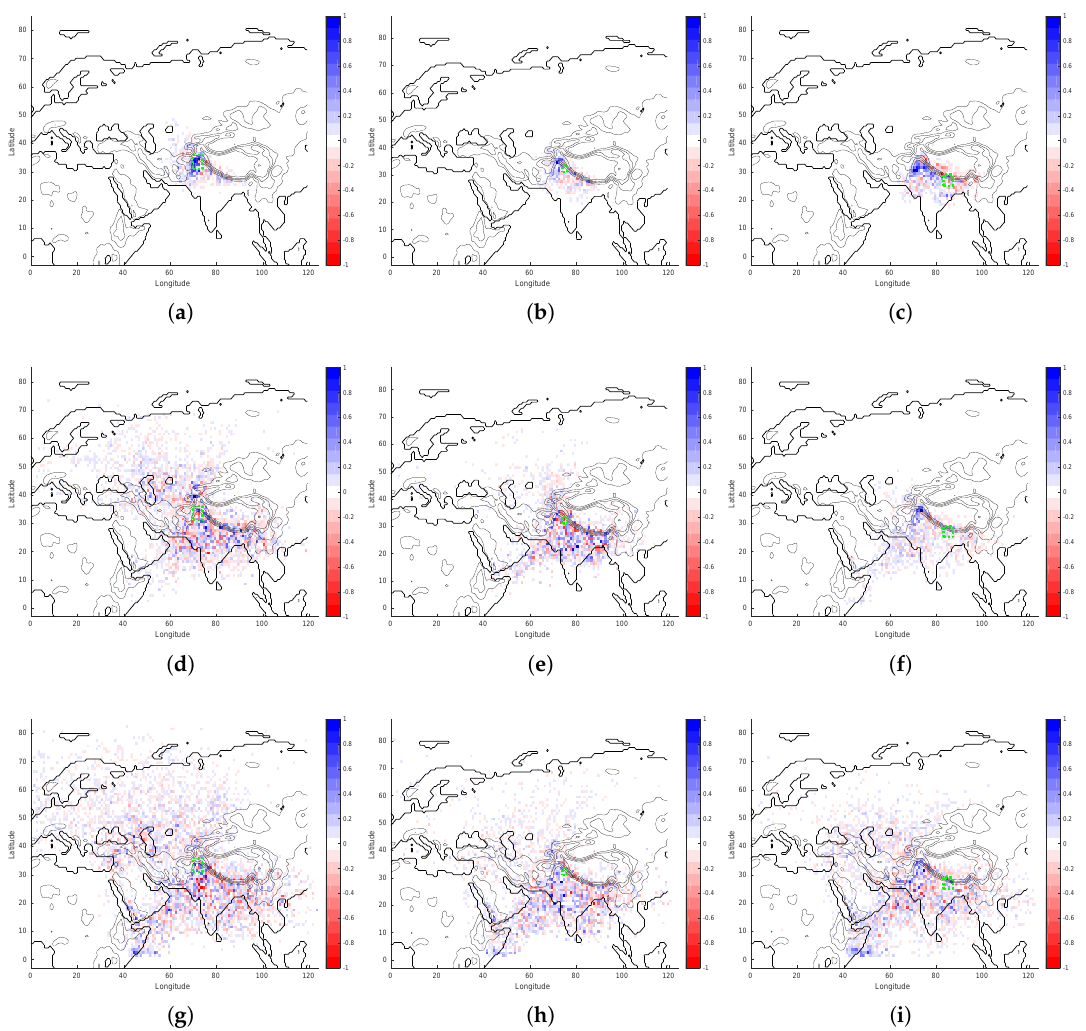
Figure 14. For the 20 strongest precipitation events for each region of interest, the column integrated moisture sources and sinks, for all parcels over each 1 ◦ area, originating from: ( a ) NP , 2 days back in time, along the parcel trajectory; ( b ) U , 2 days back in time, along the parcel trajectory; ( c ) K , 2 days back in time, along the parcel trajectory; ( d ) NP , 6 days back in time, along the parcel trajectory; ( e ) U , 6 days back in time, along the parcel trajectory; ( f ) K , 6 days back in time, along the parcel trajectory; ( g ) NP , 10 days back in time, along the parcel trajectory; ( h ) U , 10 days back in time, along the parcel trajectory; ( i ) K , 10 days back in time, along the parcel trajectory. The area of interest is illustrated by a green dashed box. The colour bar scale shows the relative difference of the change in specific